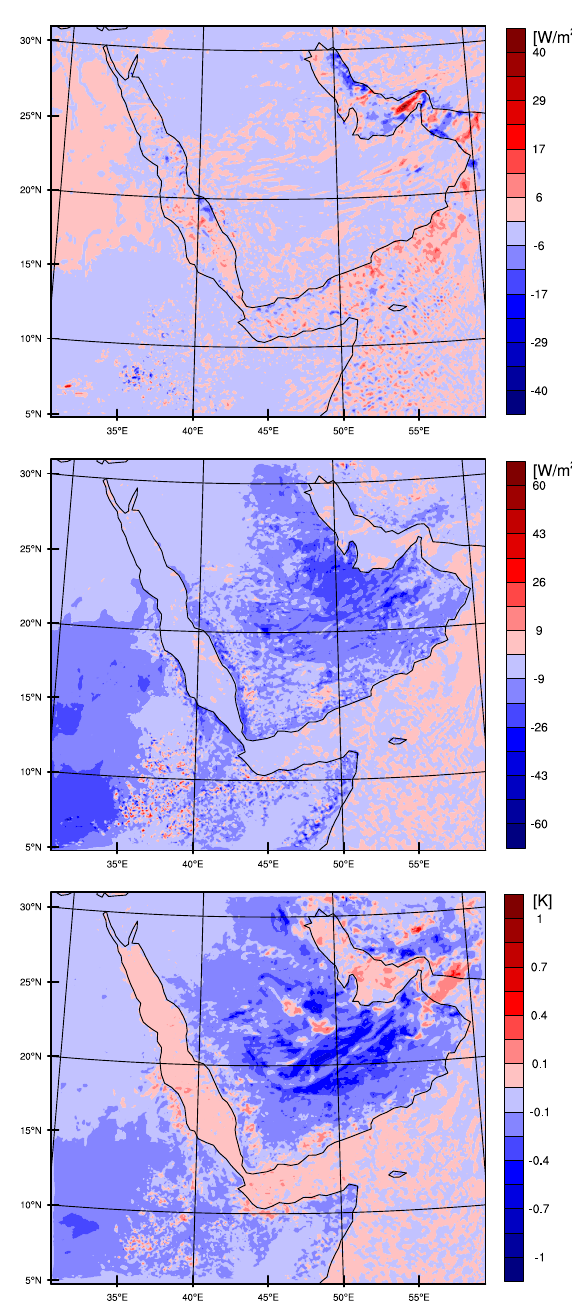
Fig. 10. Spatial distribution of dust-induced perturbations of instan- taneous (at 12:00UTC) latent heat flux [Wm − 2 ] (upper panel), sen- sible heat flux [Wm − 2 ] (middle panel), and air temperature at two- meter altitude [K] (lower panel) averaged over the simulation period of 7–20 January